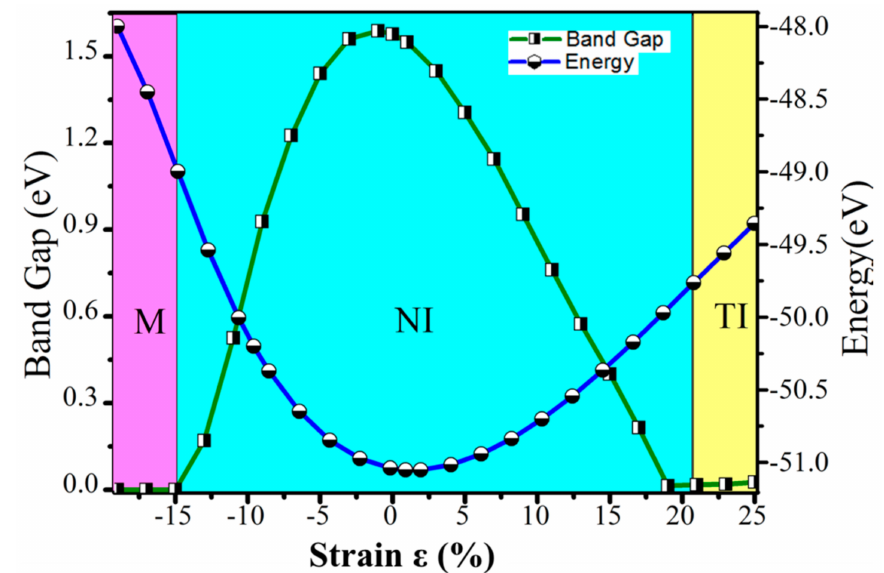
Figure 4. The energy and the band gap calculated for a SiCH 3 monolayer, as a function of external